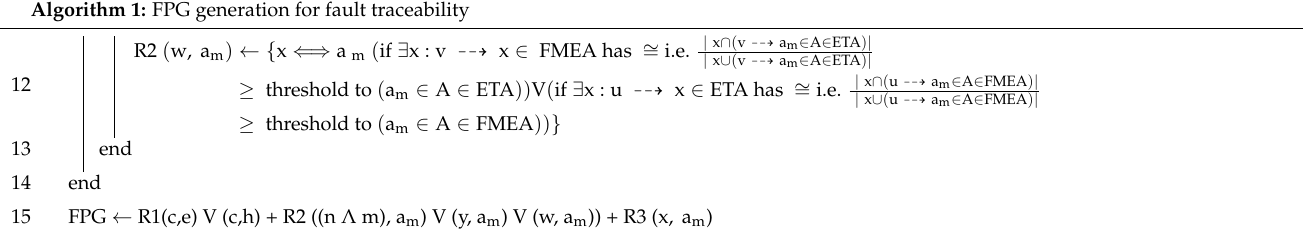
Algorithm 1: FPG generation for fault